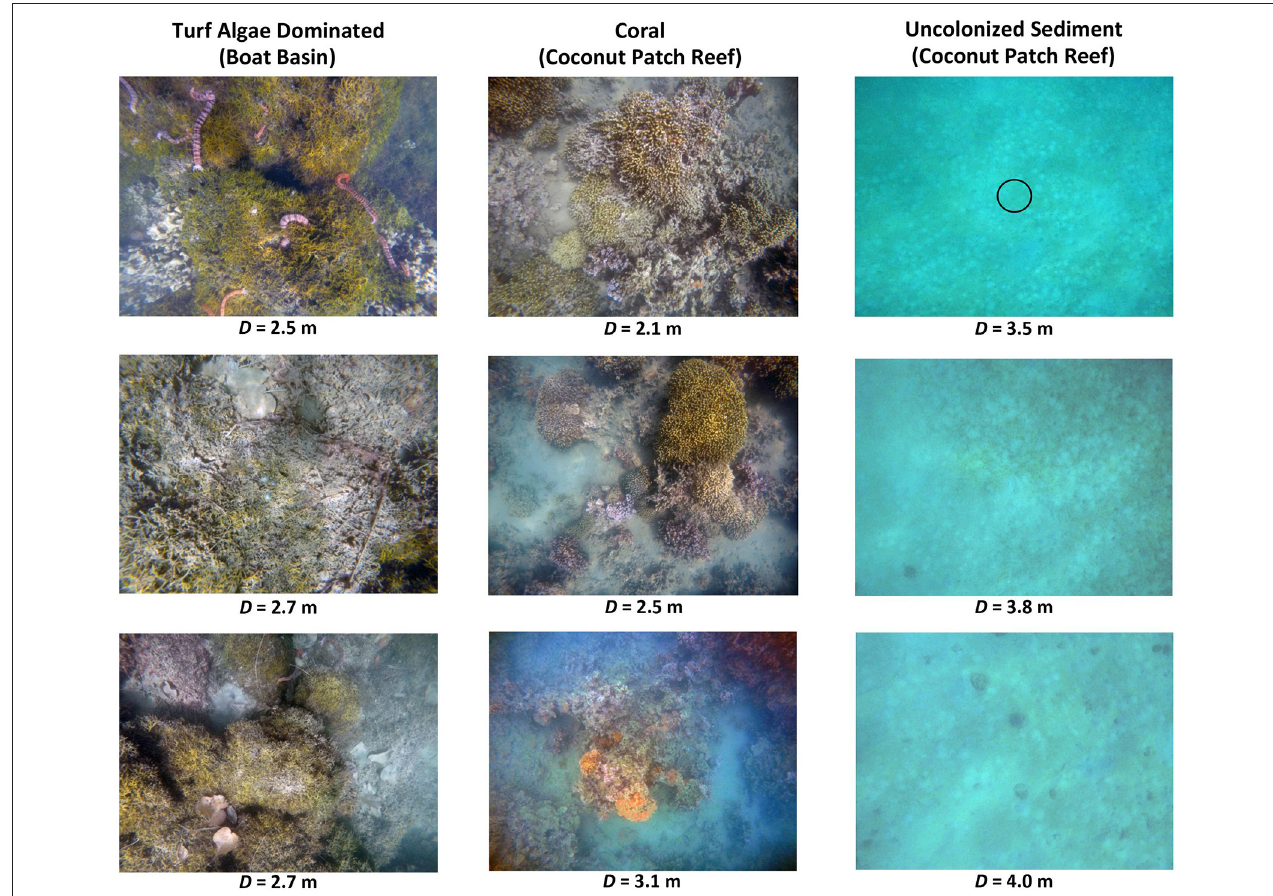
FIGURE 8 | In-water, down-looking imagery (GP1 camera) of selected benthic conditions along the ASV survey track over the coconut patch reef. The approximate field of view of the in-water, down-looking radiometer is shown as a circle centered on the top right plate representing uncolonized sediment at a depth of 3.5m.